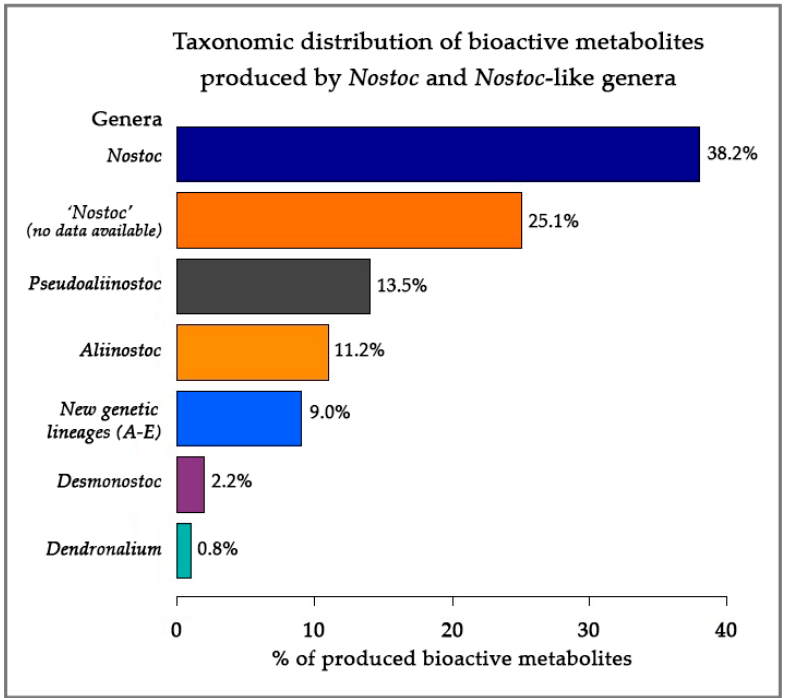
Figure 7. Taxonomic distribution of NP-producing strains assigned to Nostoc and Nostoc -like genera.